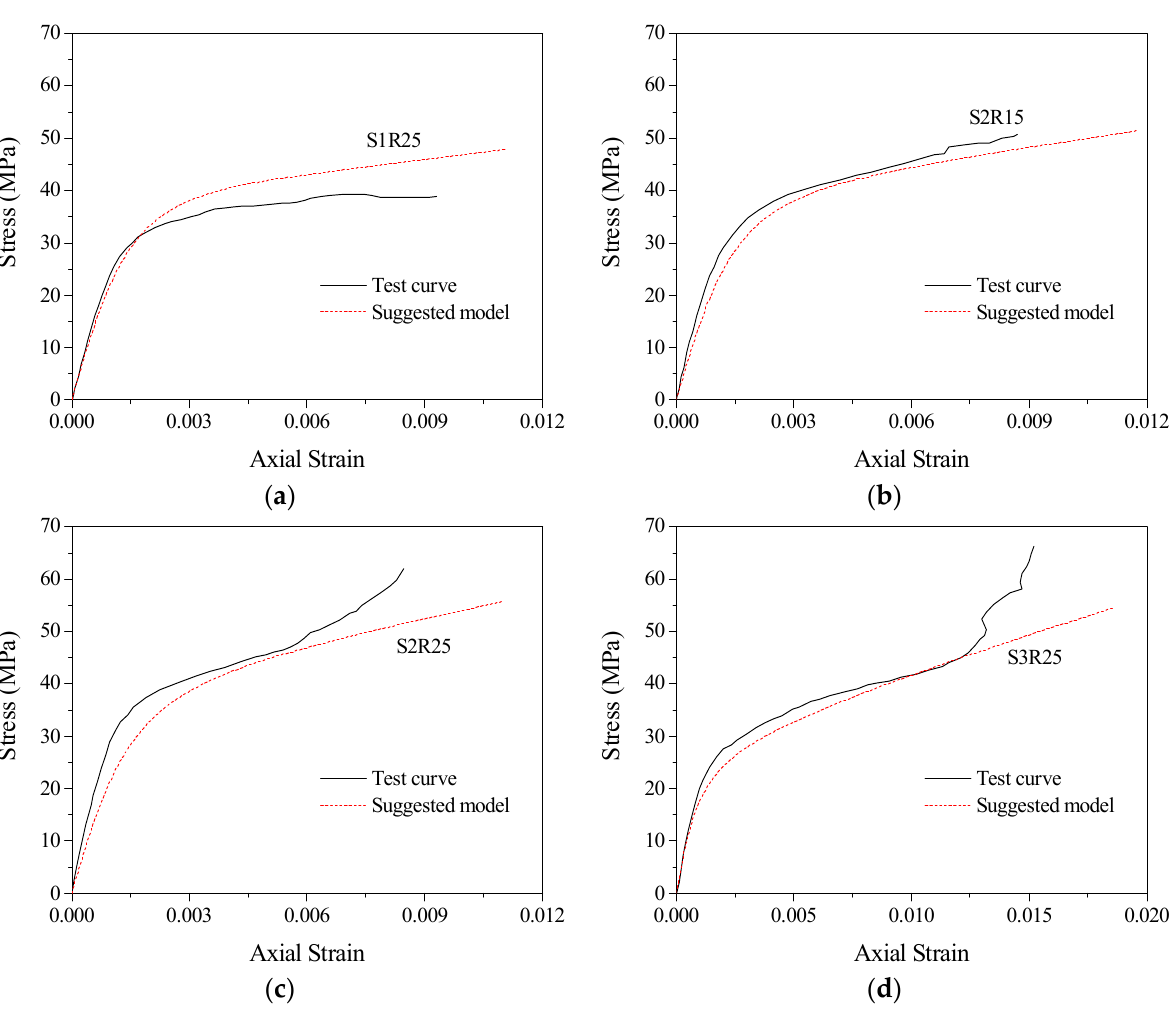
Figure 15. Performance of the stress–strain relationship curve model of FRP-confined concrete col- umns: ( a ) S1R25; ( b ) S2R15; ( c ) S2R25; ( d ) S3R25.